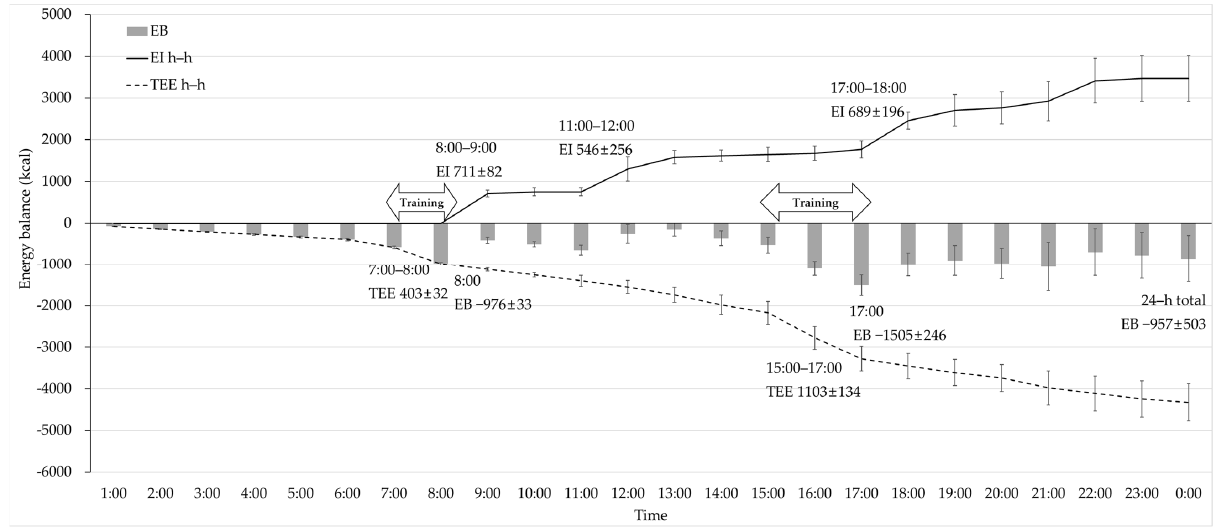
Figure 1. Hourly WDEB, EI, and total energy expenditure changes in the participants during the training days. EB = energy balance, EI = energy intake, TEE = total energy expenditure.